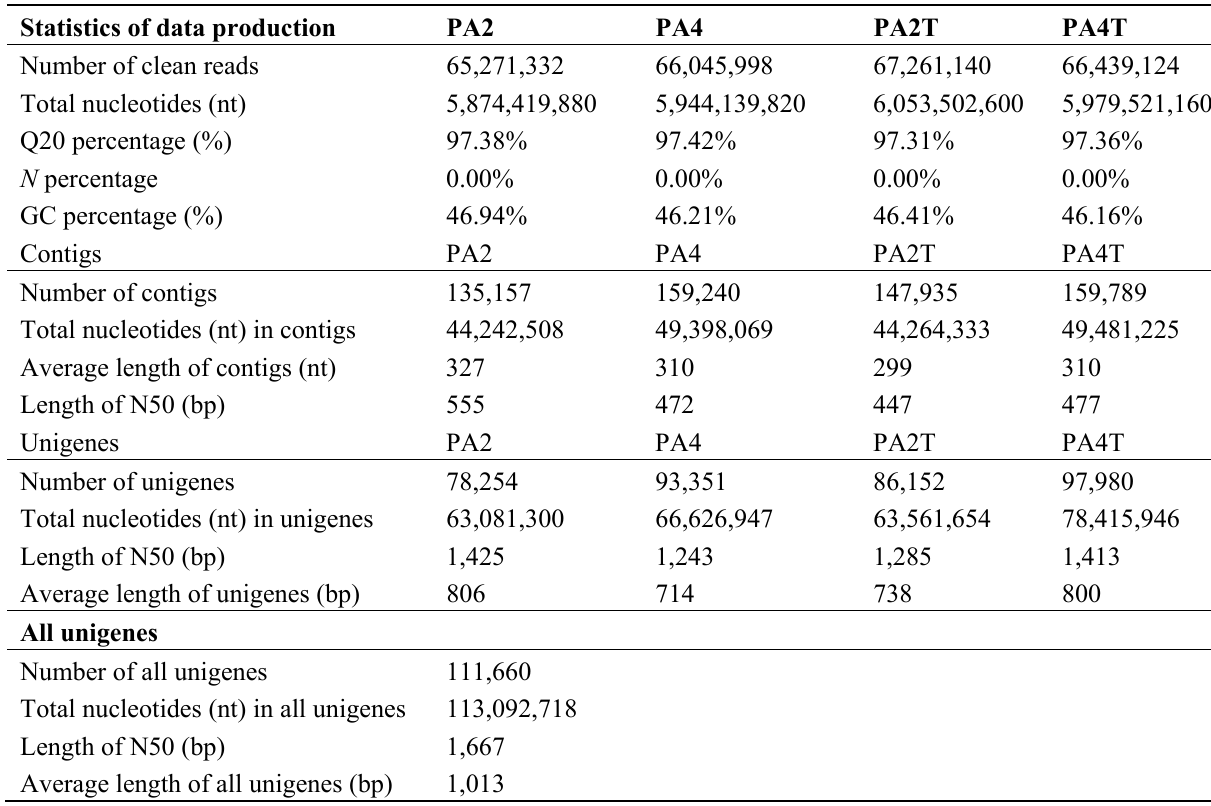
Table 1. Overview of the sequencing and assembly of the transcriptome of P. australis . Statistics of data